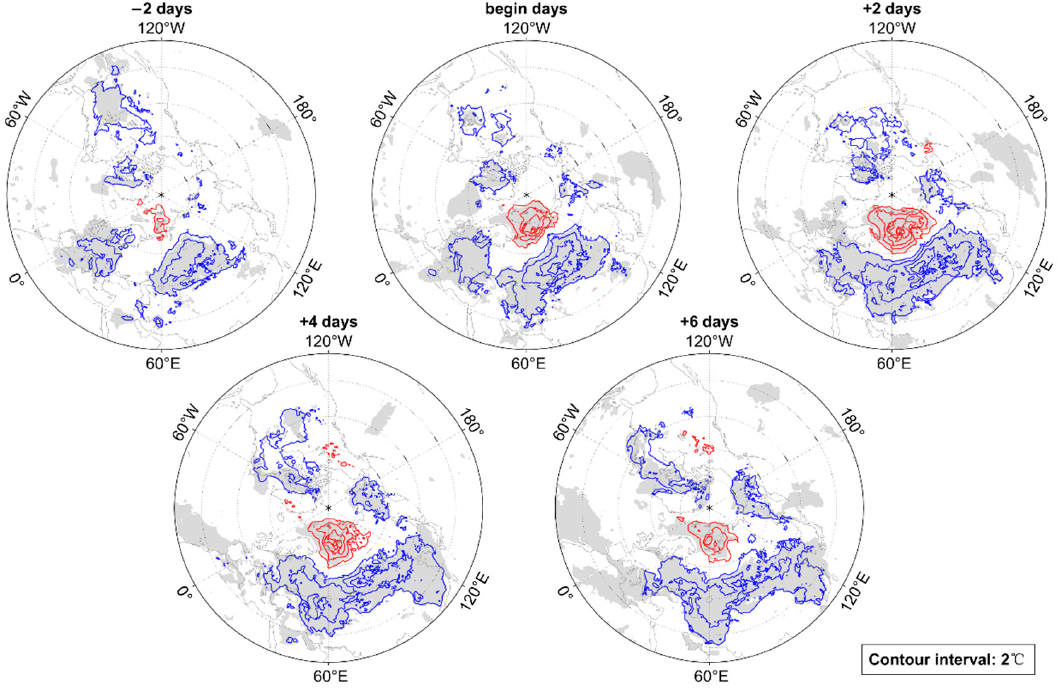
Figure 6. Synthetic analysis of the SAT anomaly field before and after the occurrence of the Ural Mountains blocking highs in the extended winter of 1979–2020 (the red line indicates a positive anomaly value, and the blue line indicates a negative anomaly value, grey shaded area through the test of significance of 95%).